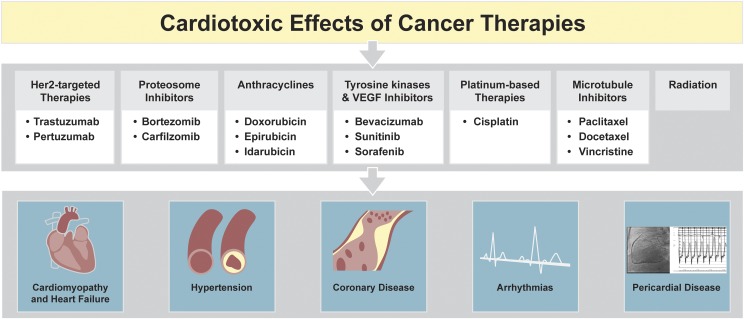
Cardiotoxic effects of cancer therapies. Although a number of targeted and untargeted cancer therapies have shown efficacy in cancer treatment, these therapies also cause cardiotoxic effects that can result in profound cardiovascular complications. Chemotherapies, including anthracyclines such as doxorubicin, tyrosine kinase inhibitors, Her2-targeted therapies, and proteosome inhibitors, are associated with vascular dysfunction and CM damage that can lead to heart failure. Platinum-based therapies, microtubule inhibitors, and radiation therapy have also been linked to arrhythmias and pericardial disease. The pathobiology or the disease mechanisms of such cardiotoxic effects of various cancer therapies have not been elucidated and must be addressed in a patient-specific manner.